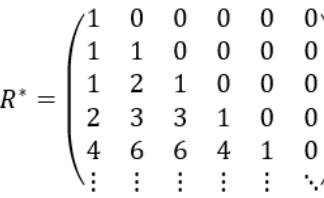
Figure 3. RNA arrays I and II.